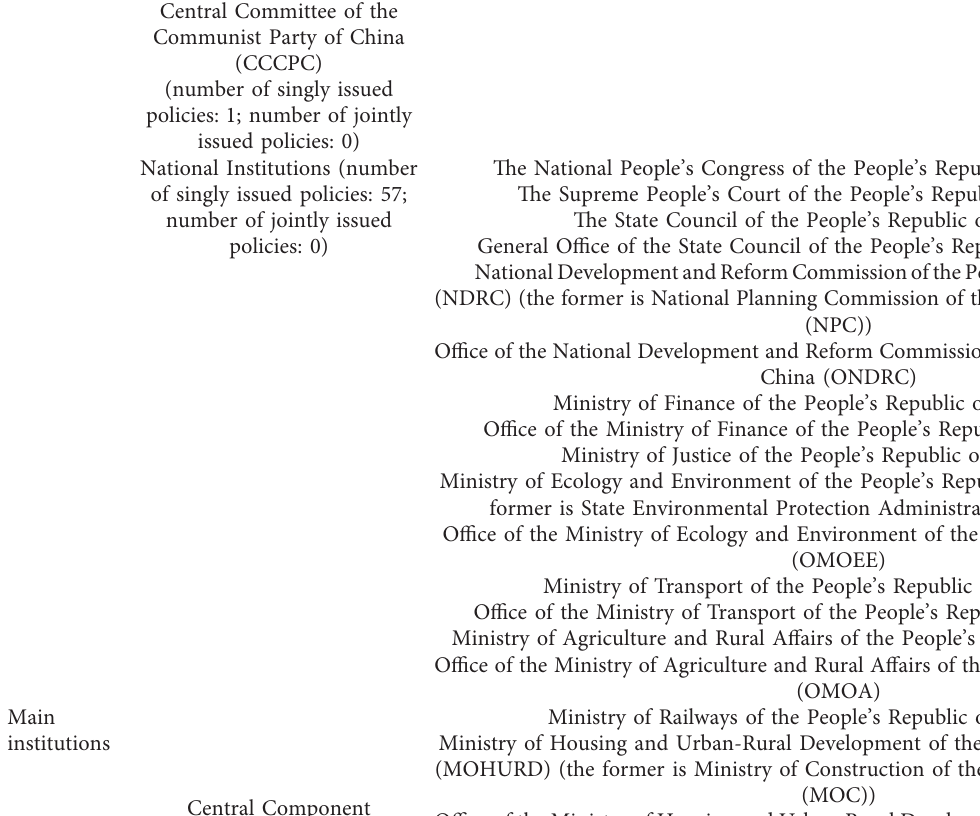
Table 1: PPPs policy entities in